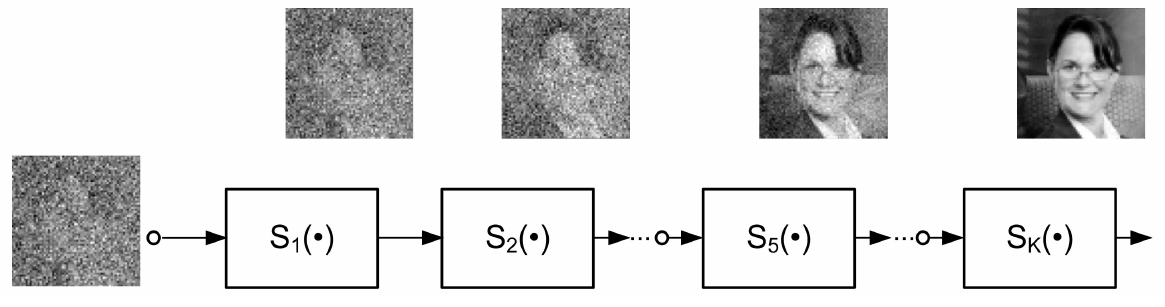
Figure 15. Multilayer learning structure (K—number of steps; e.g., K =